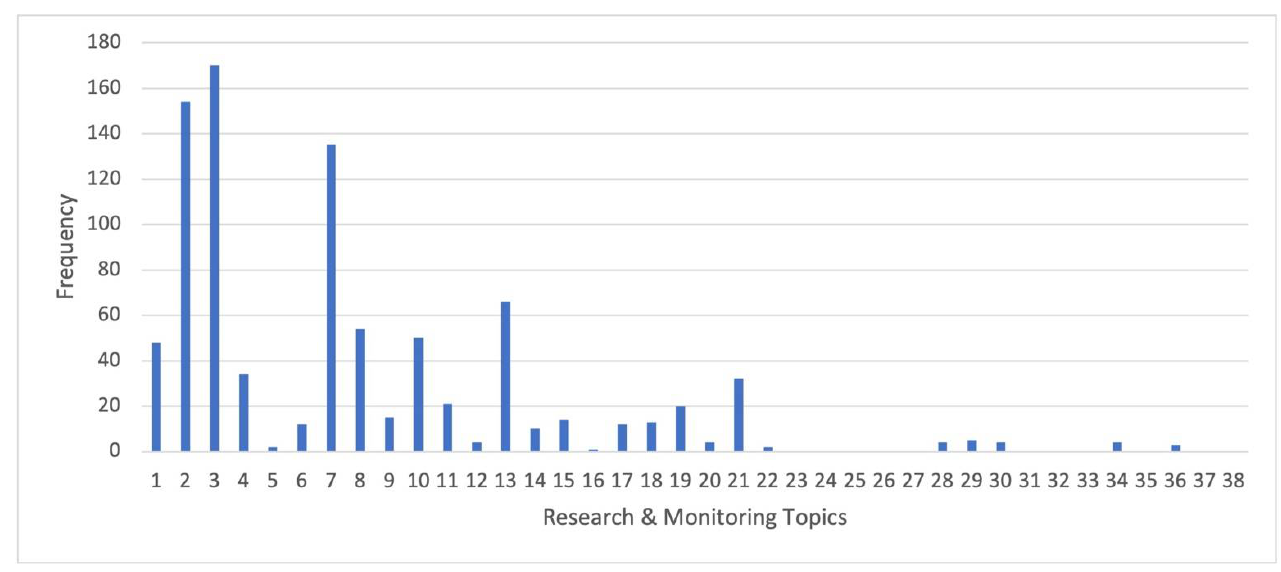
Figure 3. Frequency of peer-reviewed papers (2010–April 2021; see Supplementary Materials 1 for full list of papers), authored or co-authored by U.S. researchers, which addressed specific research and monitoring topics as pertinent to the Ross Sea region marine protected area Research and Monitoring Plan (See Table S1 for list of topics).